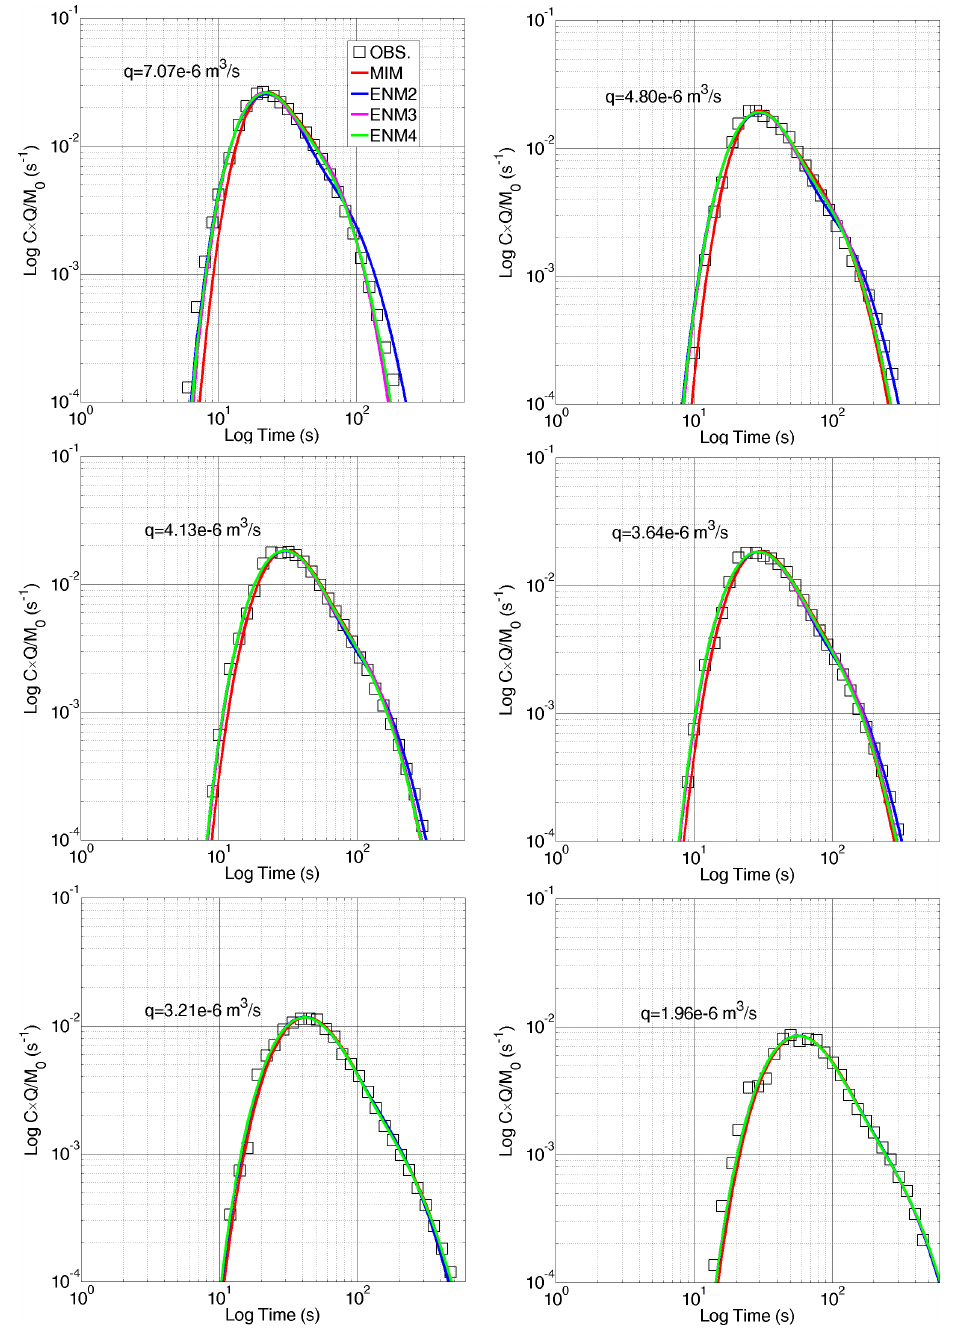
Figure 6. Fitting of BTCs at different injection flow rates using each of the four models (MIM, ENM1, ENM2,